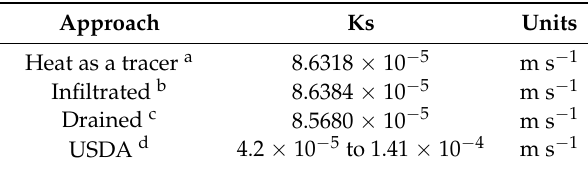
Table 2. Average saturated hydraulic conductivity determined for the three approaches and range of values reported by the U.S. Department of Agriculture (USDA) for sand texture